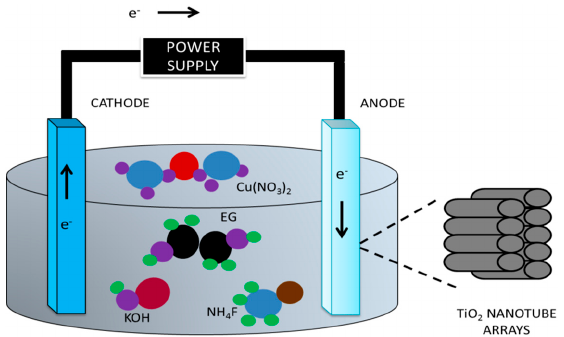
Figure 15. Schematic diagram of experimental setup for catalyst preparation via anodization process, EG = ethylene glycol.